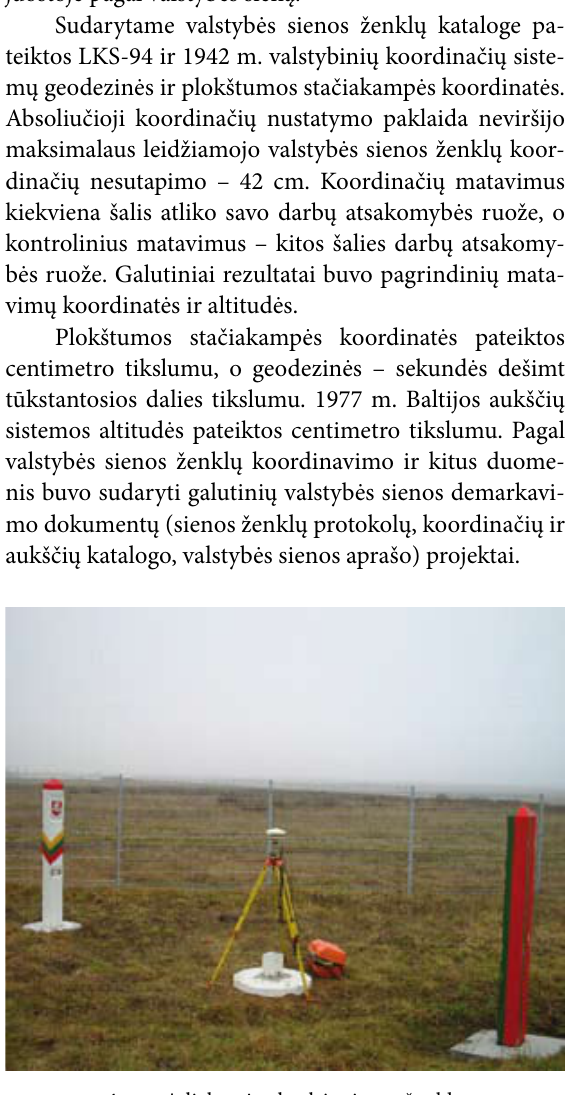
Fig. 4. State boundary sign geodetic survey